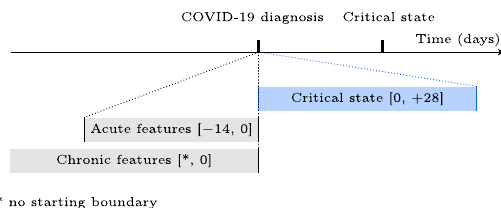
Fig. 2 Time windows for prediction target and feature extraction. Schematic illustration of time window de fi nitions relative to the COVID-19 diagnosis or to the critical state (time not to scale). The brackets de fi ne the boundaries (included) in (Fig. 2), or patients being fl agged as deceased in the database without having been in a critical state before COVID-19 diagnosis. Moreover, the sizes of the partitions for training and testing are also reported in Fig. 1. Among patients labeled as critical state, a total of 545 patients were fl agged as deceased in the Explorys database. This corresponds to 3.5% of the entire cohort. There were 11 cases of deceased patients without critical state after COVID-19 diagnosis, which represent less than 0.1% of the cohort.